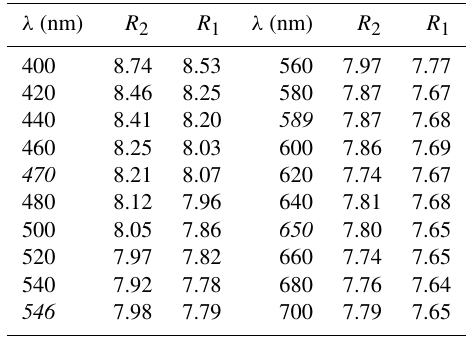
Table 1. Reflectance values (%) measured in air (COM – Commis- sion on Ore Mineralogy – wavelengths in